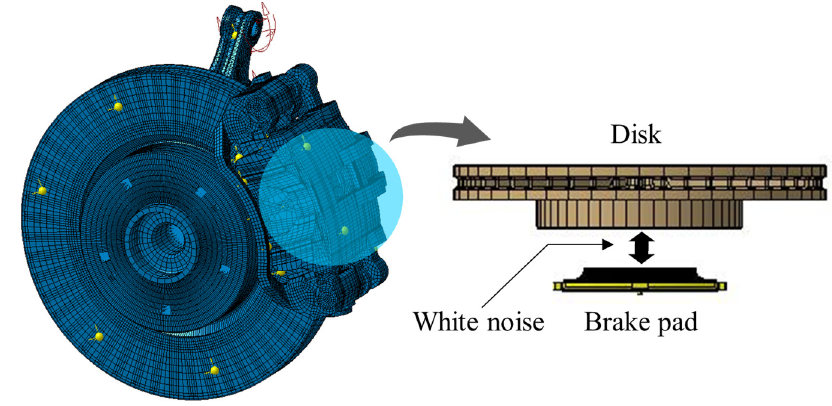
Figure 7. White-noise assignment for the assembled brake system.